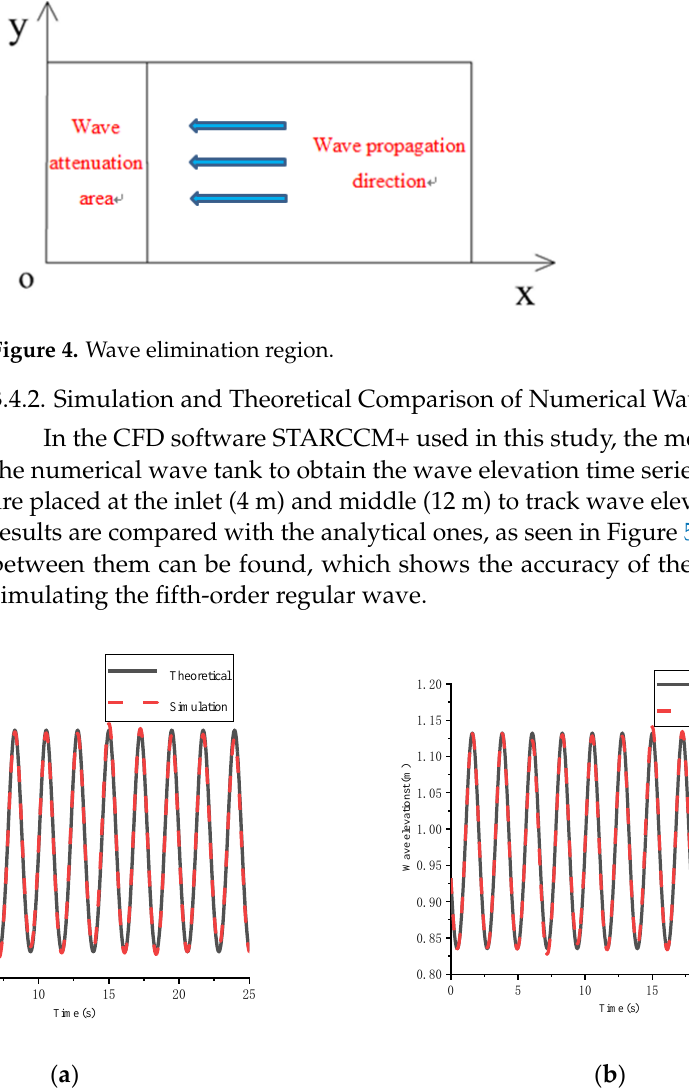
Figure 5. Comparison between theoretical numerical and waveform. ( a ) 4 m from the calculation domain entrance. ( b ) 12 m from the calculation domain entrance.